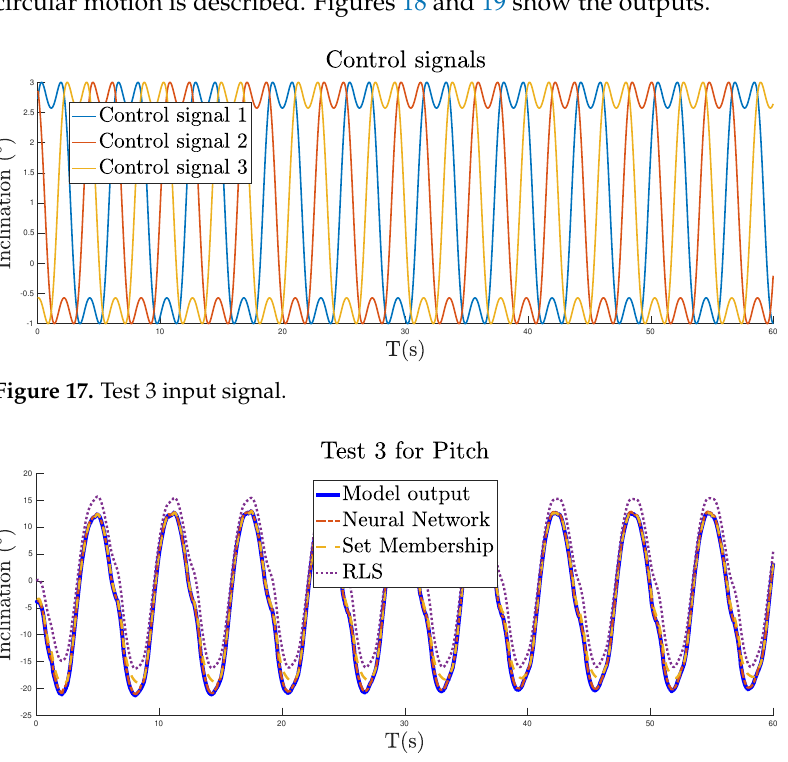
Figure 18. Test 3 results for